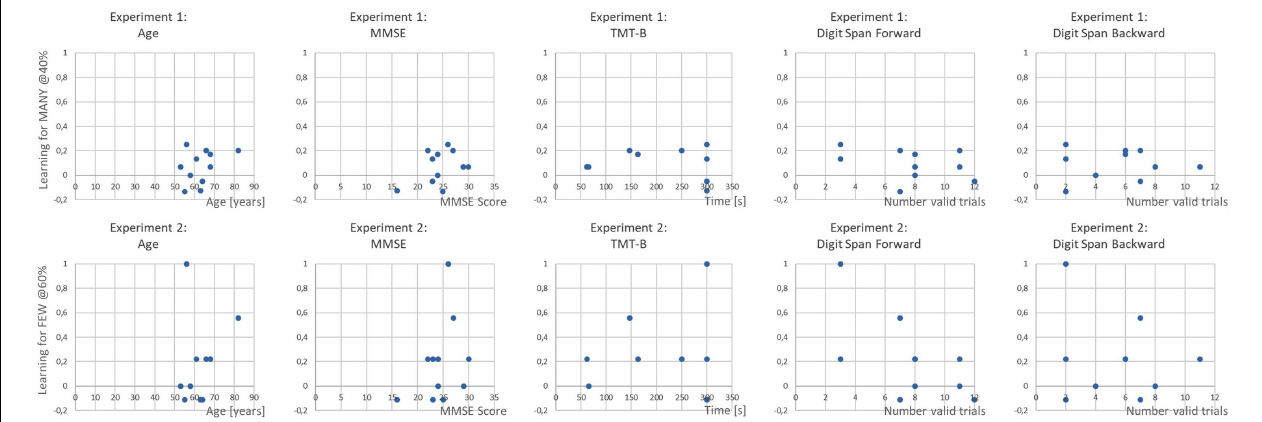
FIGURE 5 | Scatterplots illustrating the relationship of the direct learning effects in Experiment 1 at proportion 40% (upper panel) and in Experiment 2 at proportion 60% (lower panel) with the patients demographic and neuropsychological